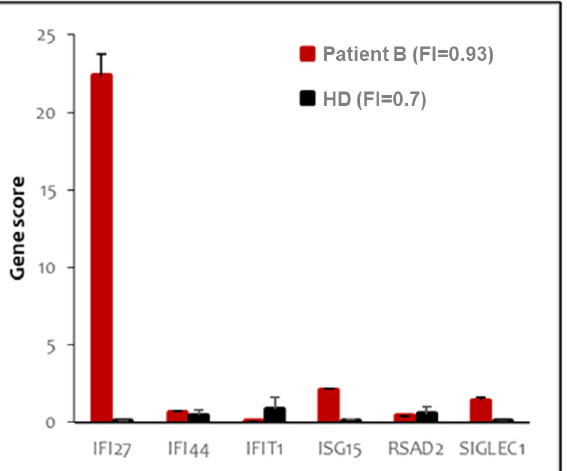
Figure 3. Peripheral blood type I interferon signature of patient B. The panel shows the expression of six type I-IFN stimulated genes, indicated in the X axis. Red bars indicate expression levels in patient B; black bars represent the average of twenty healthy donors. Interferon score (FI) is indi ‐ cated in the legend.